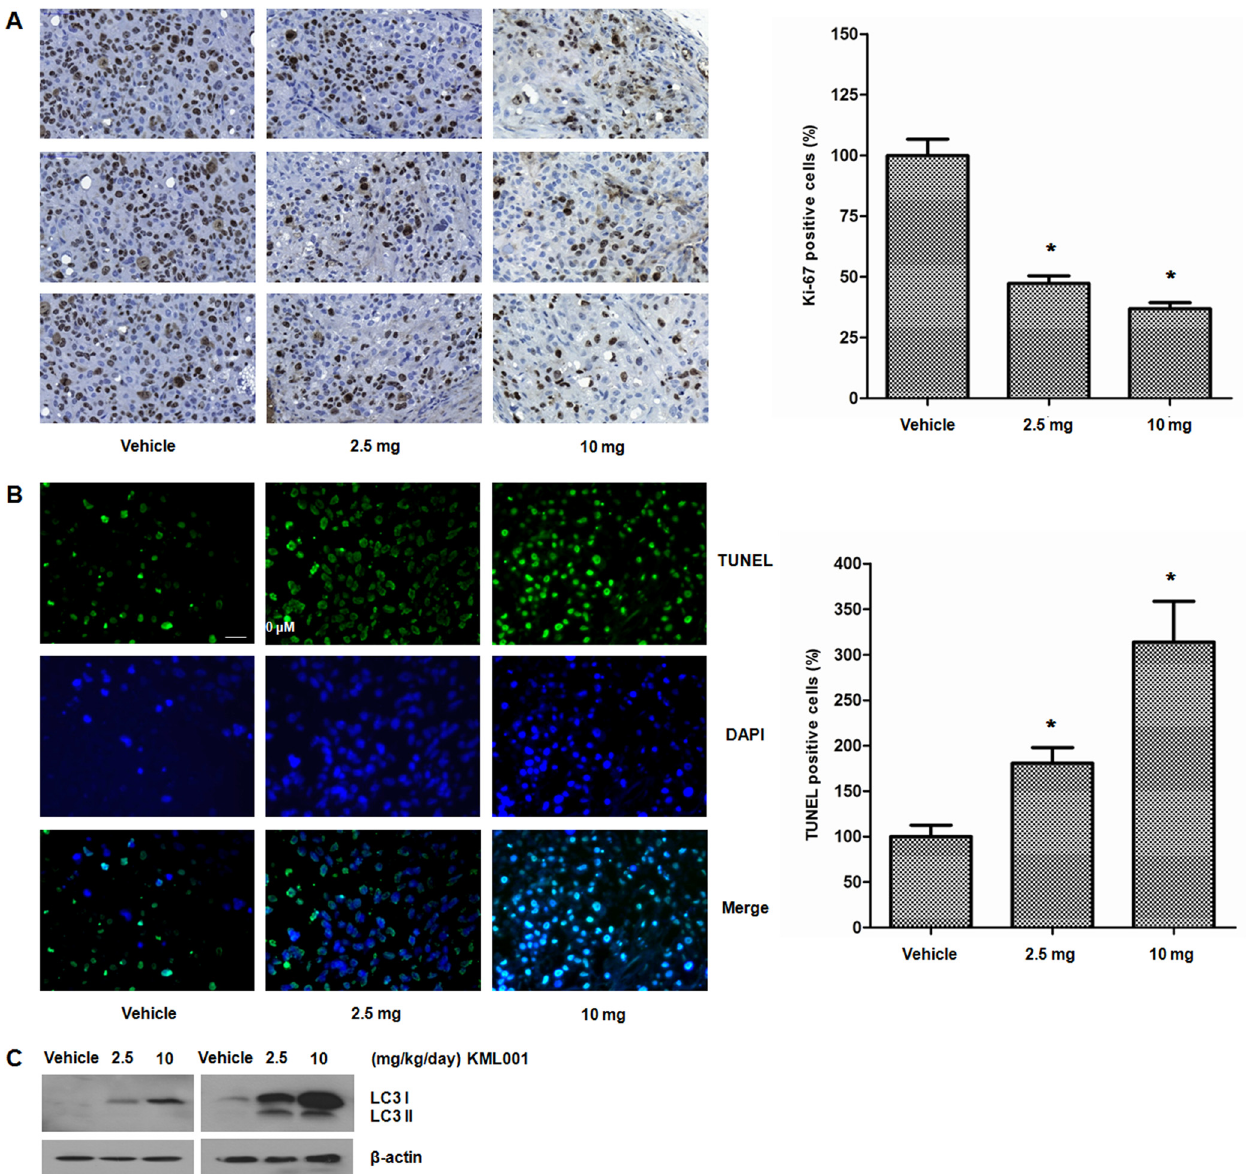
Fig 7. KML001 treatment has (A) anti-proliferative effect, (B) apoptotic effect, and (C) autophagic effect on DU145 prostate cancer cells in mice. Three fields in each mice were observed by fluorescence (200×) and bright field microscopes (200×), respectively. Representative images of each treatment group were shown. Vehicle and KML001 group mice orally received saline and KML001 (2.5 or 10 mg/kg/d) for 4 weeks, respectively. * p < 0.05 vs.